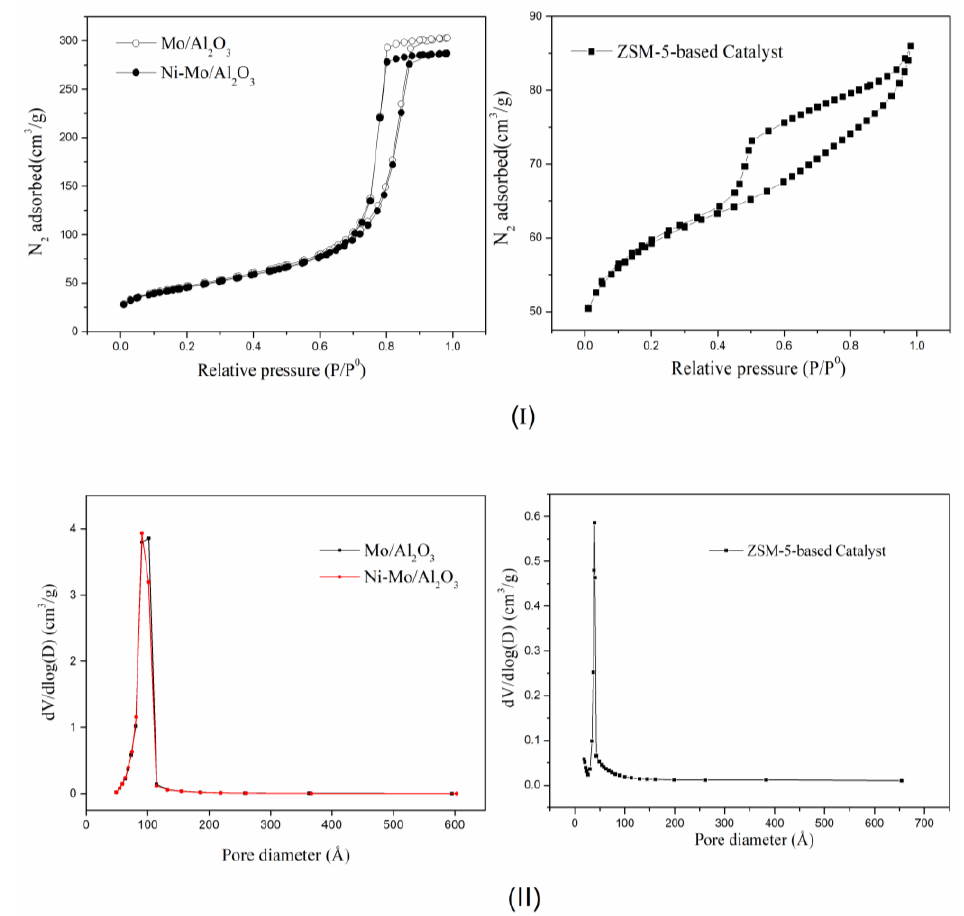
Figure 2. ( I ) N 2 adsorption-desorption isotherms for Mo/Al 2 O 3 , Ni-Mo/Al 2 O 3 , and ZSM-5-based catalysts. ( II ) Pore size distribution of the catalysts.